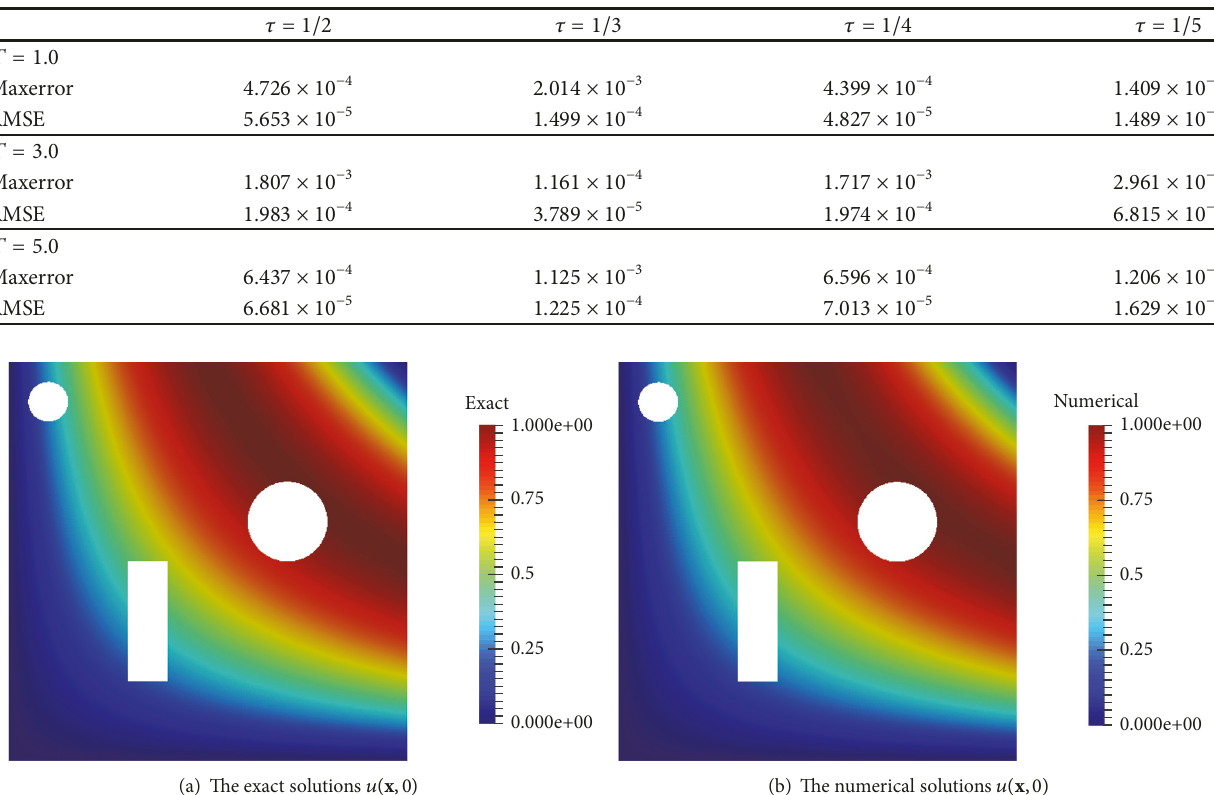
Figure 12: The figures of exact and numerical solutions of 𝑢(𝑥,𝑦, 0) .